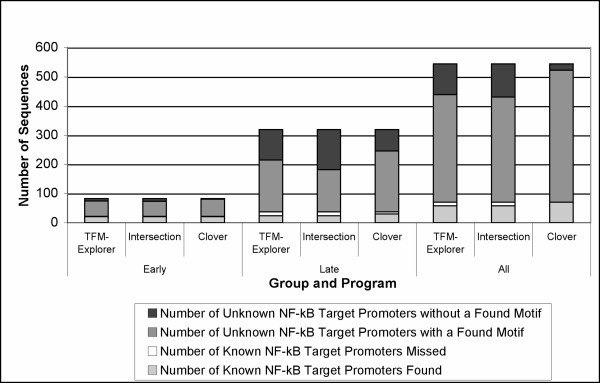
Computational identification of NFκB binding site motifs at human orthologs of genes from Early, Late, and a combined All groups predict putative NFκB genes responding to S. Choleraesuis. Each bar graph shows (for Clover, TFM-Explorer, or the intersection of these results) for each group: a) the number of known target genes whose promoter contains a NFκB motif (light gray), b) the number of known target genes whose promoter was not identified as having a NFκB motif (white), c) the number of unknown NFκB target genes whose promoter was identified as having a motif (dark gray), and d) the number of unknown target genes whose promoter was not identified as having a NFκB motif (black).